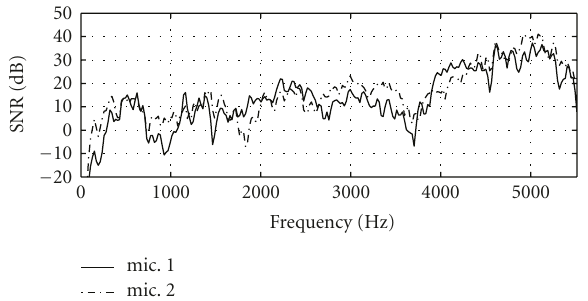
Figure 1: Input SNR values for a driving situation at a car speed of 100